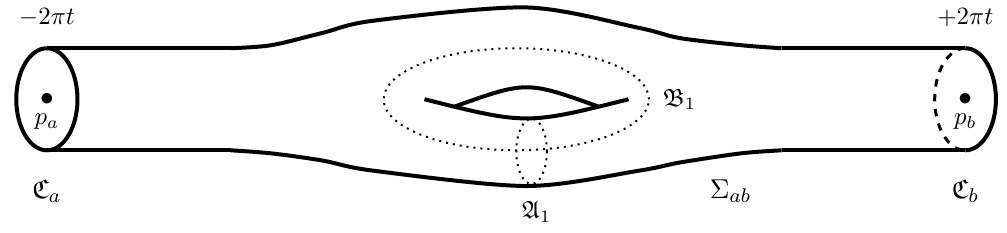
Figure 3 . The surface (cid:6) ab is obtained from (cid:6) in the vicinity of the non-separating degeneration limit by cutting (cid:6) along a cycle homologous to A 2 and adjusting the position of the cycle so that C a and C b are level sets for f = (cid:6) 2 (cid:25)t . two punctures p ; p ), but in a small but (cid:12)nite neighborhood of this limit. To a b